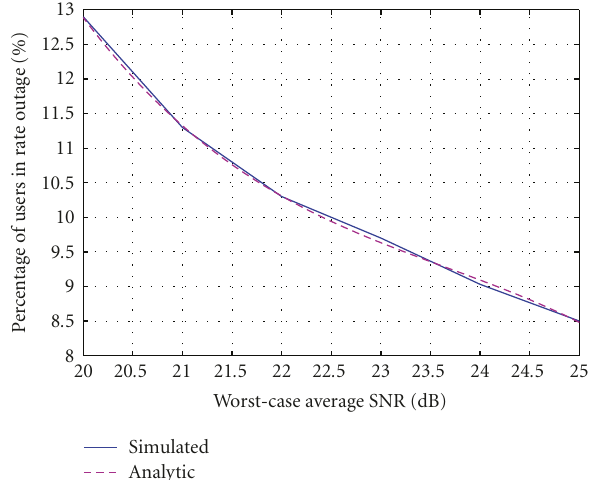
Figure 13: Average percentage of users in rate outage versus the worst-case average SNR for U = 100 users and R cut = 120m.